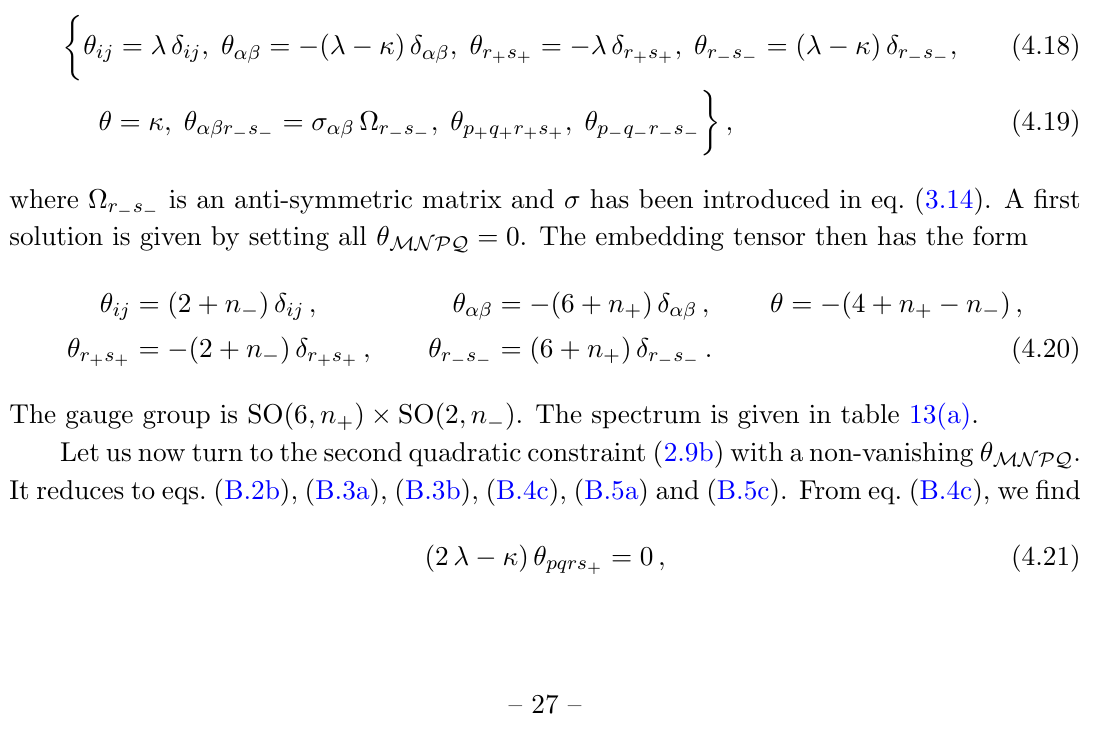
Table 12. Mass spectra for the F(4) solutions with (a) chiral and (b) diagonal embeddings (2.21b). (cid:12)rst factor of SO(8) SO( n ) SO(8 ; n ). The potentially non-vanishing components of the (cid:2) (cid:26) embedding tensor are then given